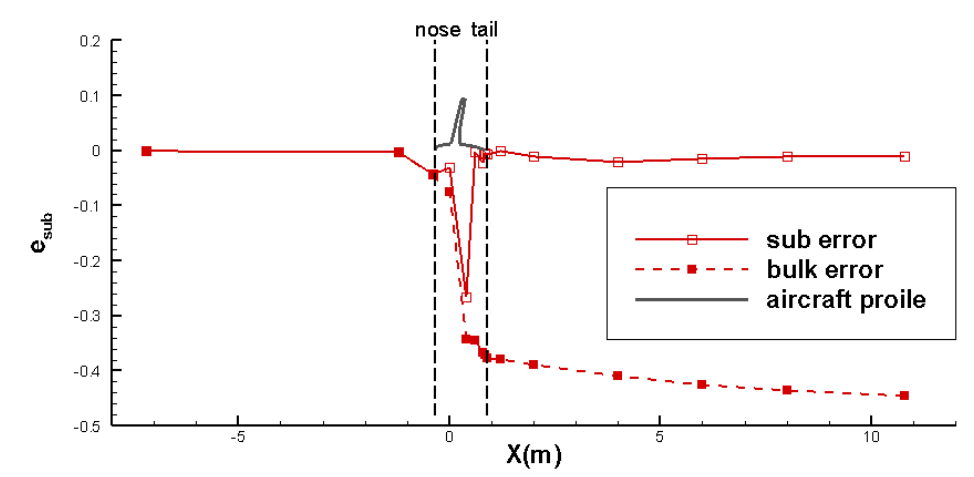
Figure 10. Subdomain error study of wing body configuration (unstructured medium mesh).